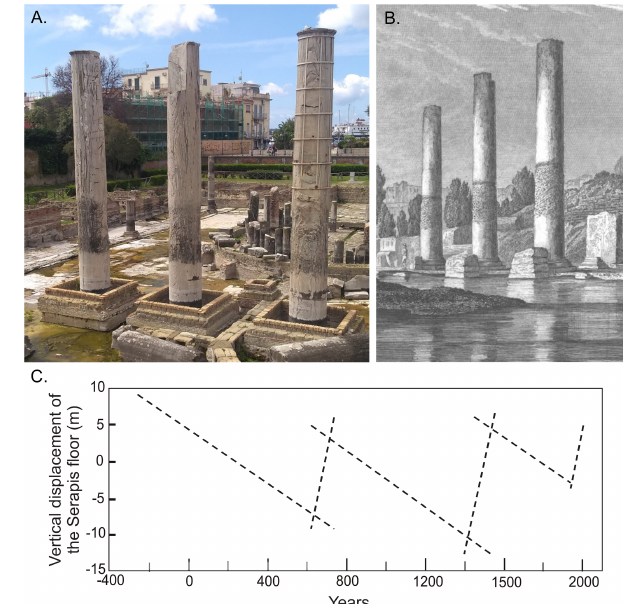
Figure 6. Roman ruins of the Serapis Temple (Macellum of Poz- zuoli), in Pozzuoli, Italy. (a) Recent picture. (b) The illustration on the frontispiece of volume I of Principles of Geology (Lyell, 1835). Both highlight the rough texture of the intermediate portion of the columns where bivalve wear is evident, indicating marine transgres- sion after the temple’s construction. (c) Vertical movements of the Serapis Temple show an alternating pattern of elevation and sub- sidence produced by bradyseism (modified from Bellucci et al.,